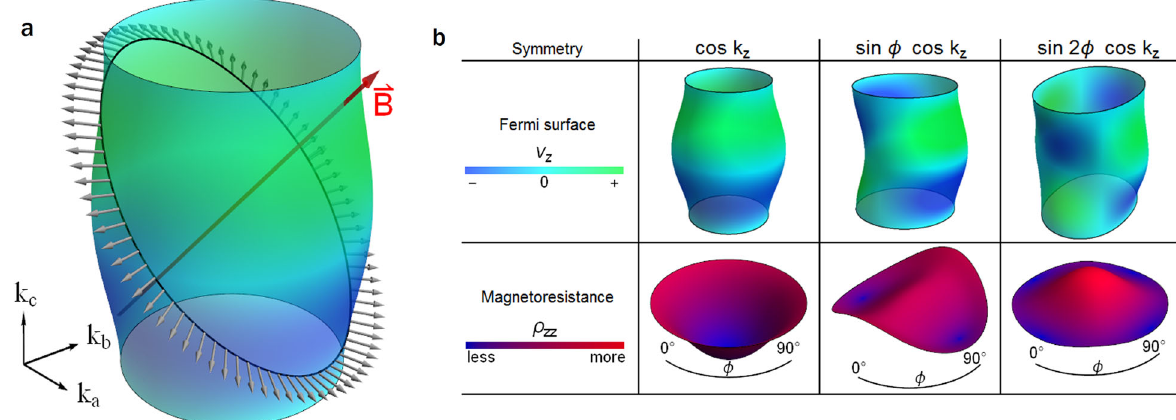
Fig. 2 Quasiparticle trajectory and magnetoresistance for different interlayer tunneling symmetries. Schematic Fermi surface with a cyclotron orbit. a Quasiparticles experience a Lorentz force in a magnetic fi eld ( red arrow ), inducing cyclotron motion perpendicular to the fi eld direction. Gray arrows indicate the Fermi velocity along a cyclotron orbit ( black line ). Dispersion along the k z direction modulates the ^ z component of the velocity and changes the sign of v z around the cyclotron orbit. Panel b shows the three dominant ĉ -axis dispersion shapes allowed by symmetry in YBa 2 Cu 3 O 6.58 ( top panels ) and their subsequent contributions to the AMR ( bottom panels ). Full rotational symmetry is preserved for the cos k z dispersion, while sin ϕ cos k z has C 2 symmetry. sin2 ϕ cos k z has C 2 symmetry but produces C 4 symmetric AMR once all cyclotron orbits are accounted for. For clarity we have presented these Fermi surfaces with isotropic k F to emphasize the symmetry of the warping: in Fig. 4a these warpings will be superimposed on the actual diamond-like k F that we obtain from modeling the